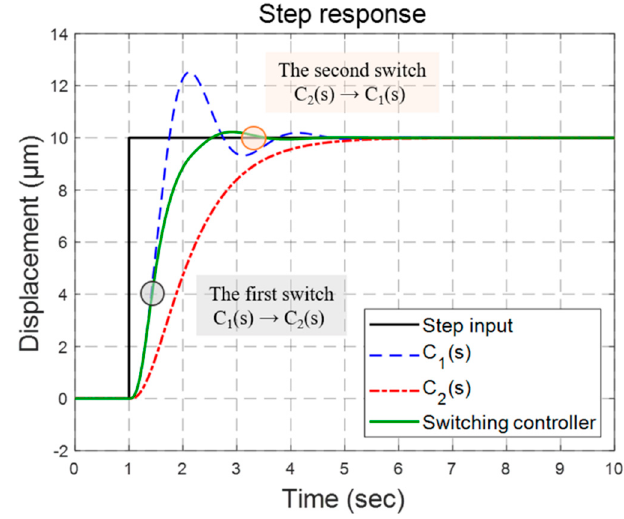
Figure 2. Response improvement by the switching control.